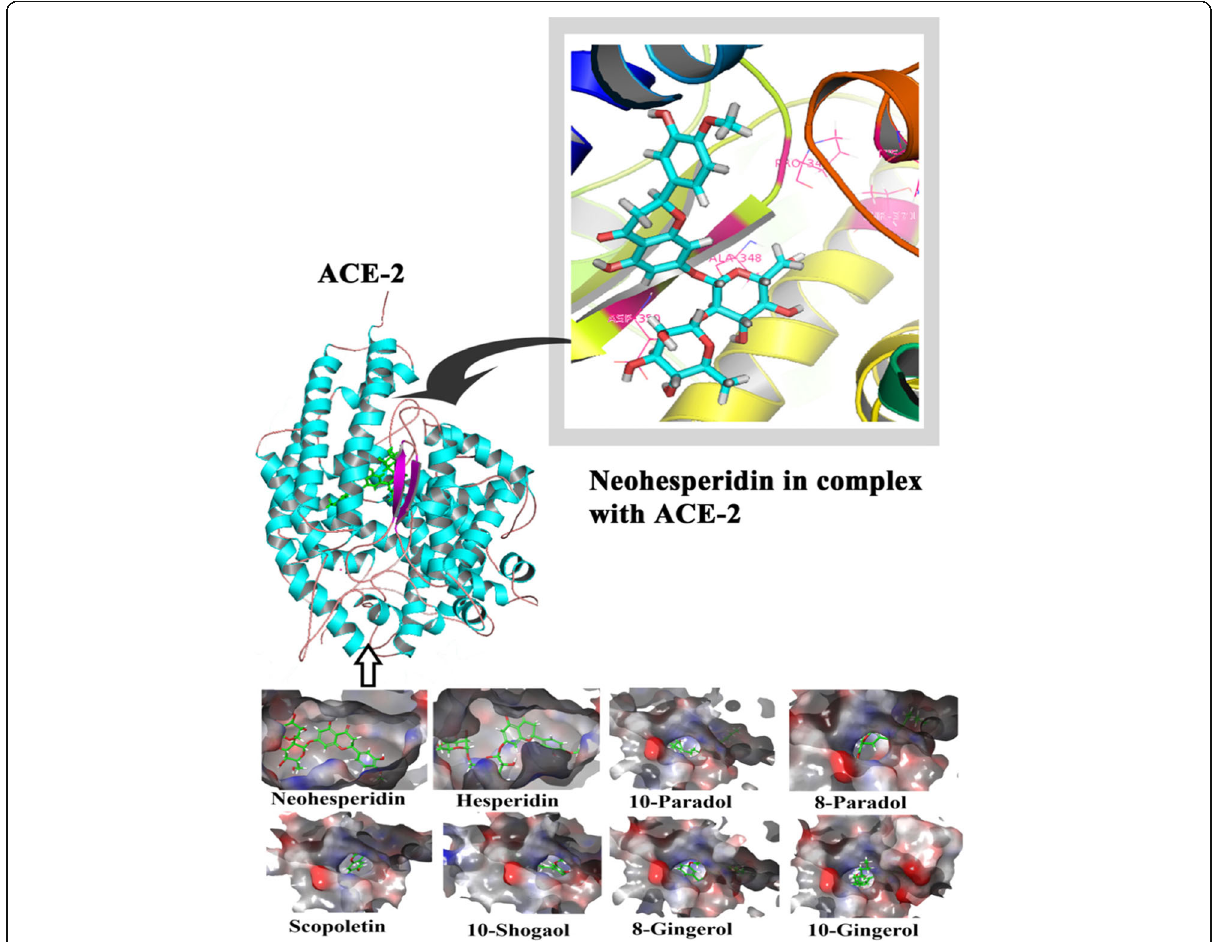
Fig. 4 Docked postures of the phytocompounds onto the active site of the